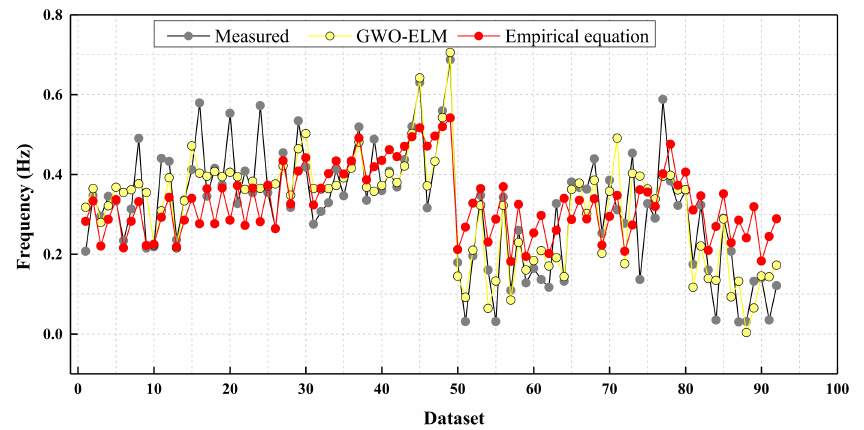
Figure 15. Performance differences in frequency